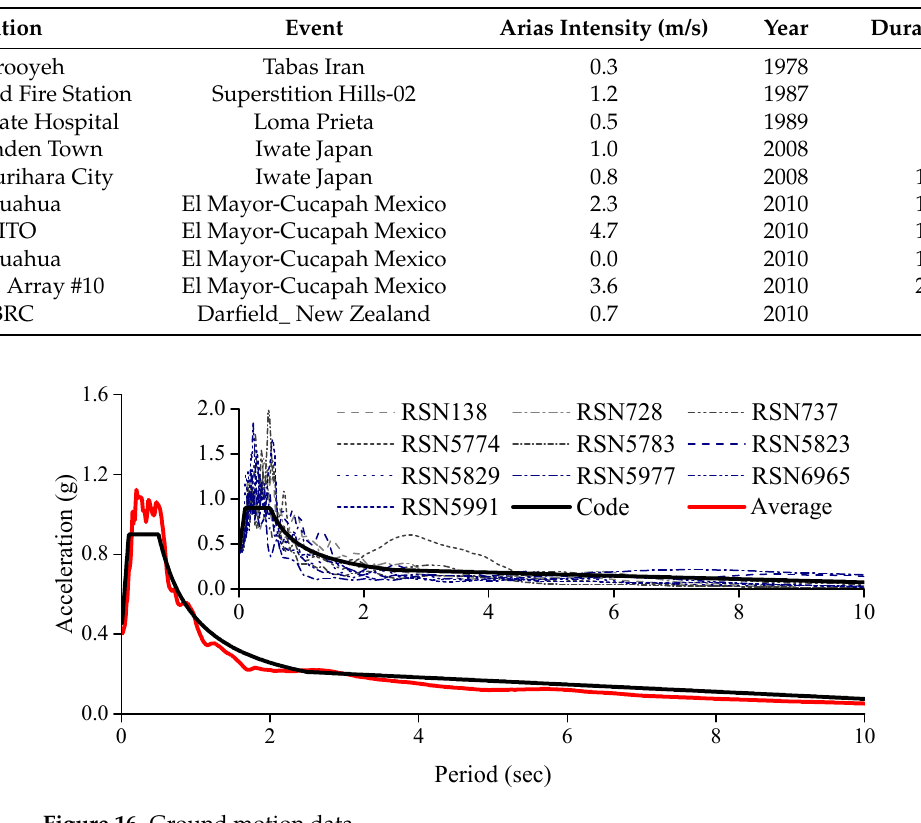
Table 7. Ground motion information.